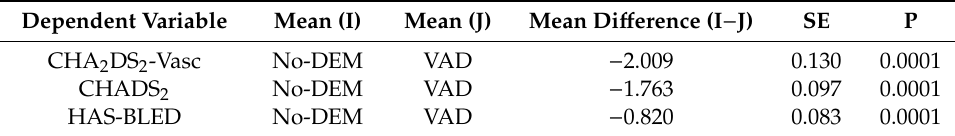
Table 2. Comparison between subgroups of patients a ff ected by atrial fibrillation